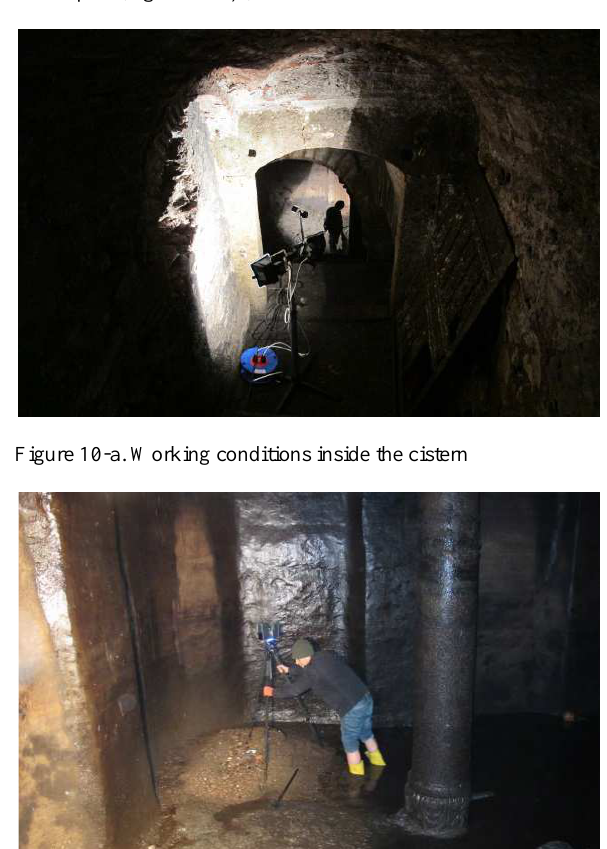
Table 1. Analyzing results of mesh models from different levels of